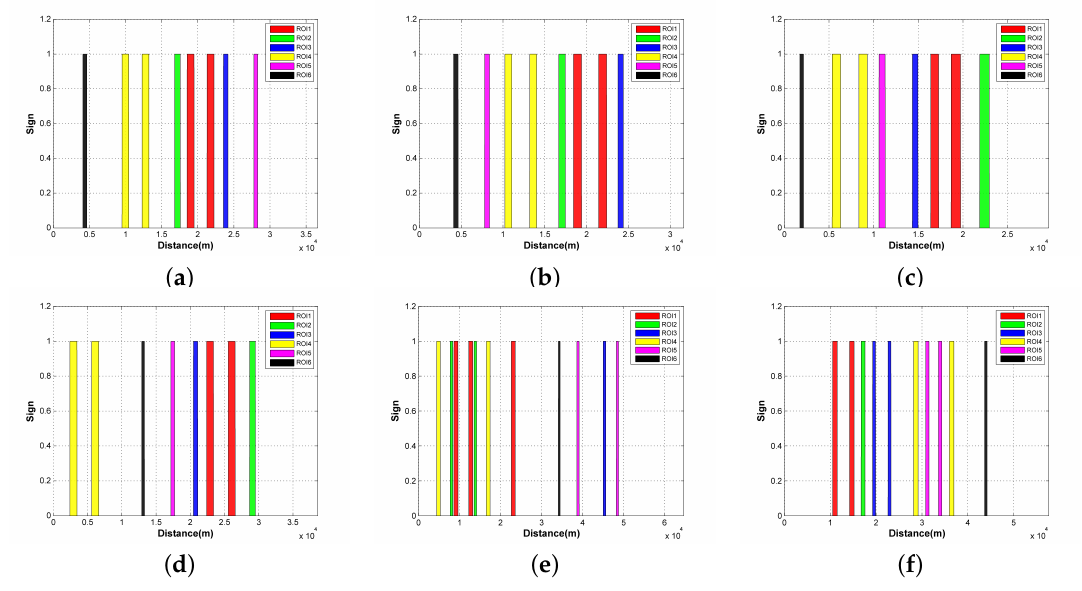
Figure 20. Operating functions of the designed paths. ( a ) path in Figure 14a; ( b ) path in Figure 14b; ( c ) path in Figure 14c; ( d ) path in Figure 14d; ( e ) zigzag path in Figure 19a; ( f ) zigzag path in Figure